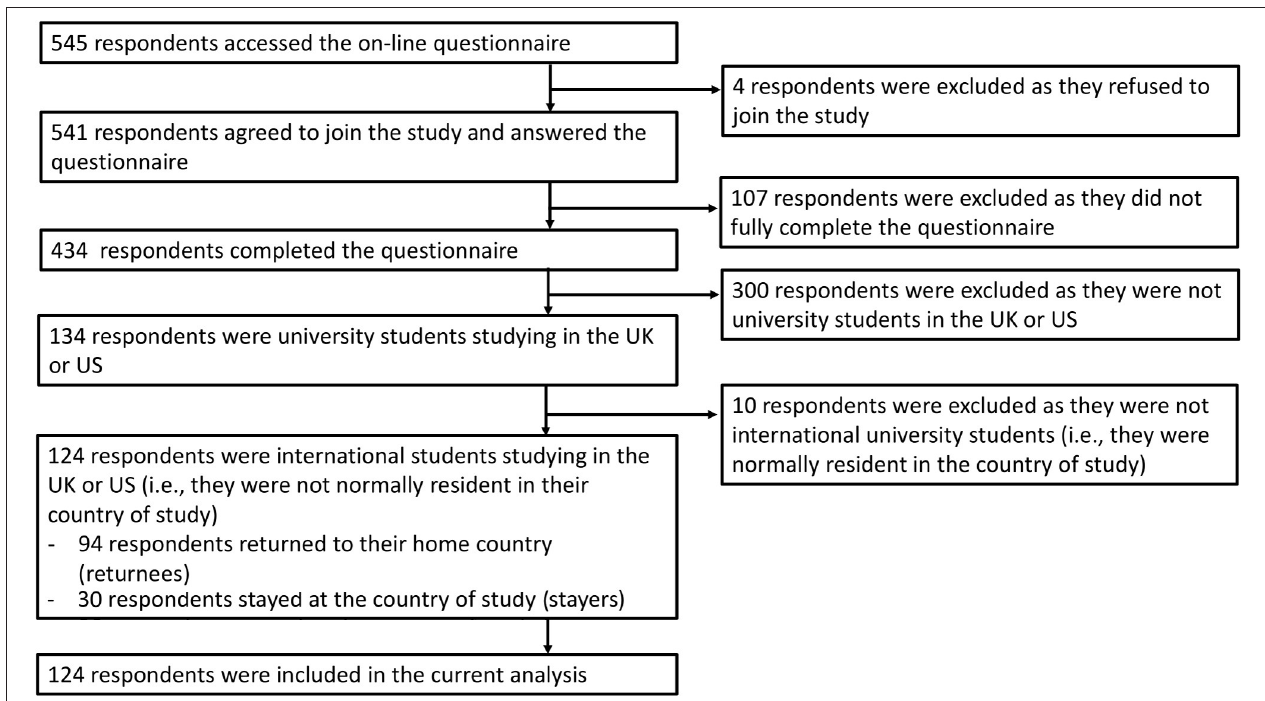
FIGURE 1 | Recruitment flow